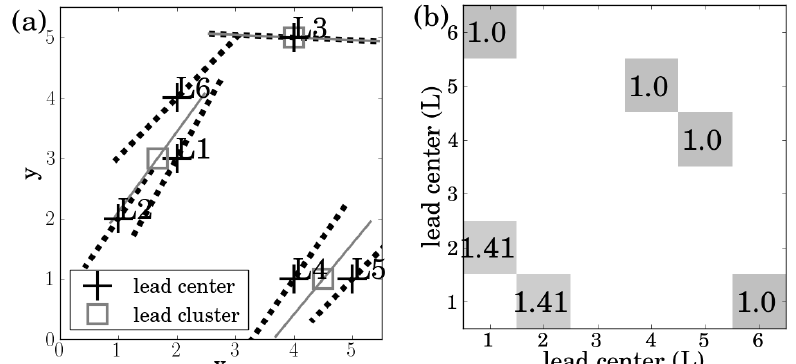
Figure 3. Principle of the cluster algorithm: Leads (black dotted lines) are reduced to lead centers (black cross, abbreviated to L) in a test data set ( a ). The numbers in the proximity matrix ( b ) represent the distance between the lead centers. All distances greater than the maximal distance d = 2 are whitened. Intersecting rows and columns with an entry identify lead clusters belonging to one cluster. The clustered lead centers are depicted as gray squares and the clustered leads as gray lines